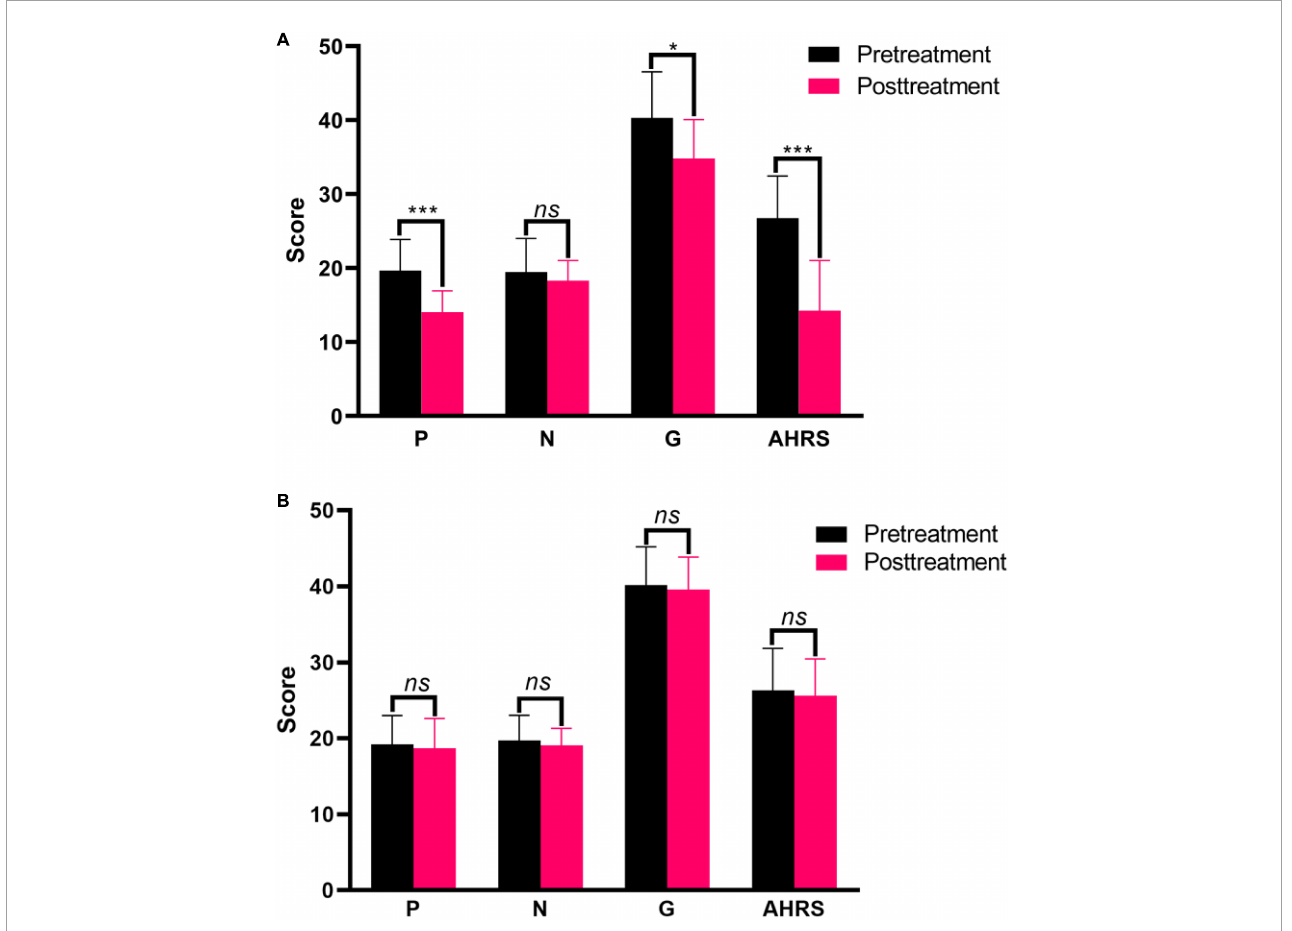
FIGURE2 Clinical symptom responses between before and after treatment in the active treatment group (A) and placebo group (B) . * p < 0.05, *** p < 0.001. ns, non-significance.